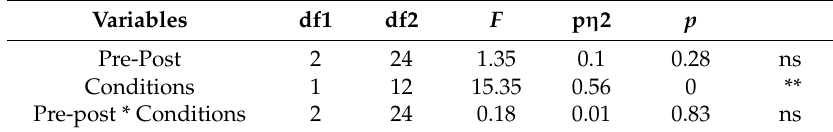
Table 7. The result of ANOVA of RSA of the healthy group.